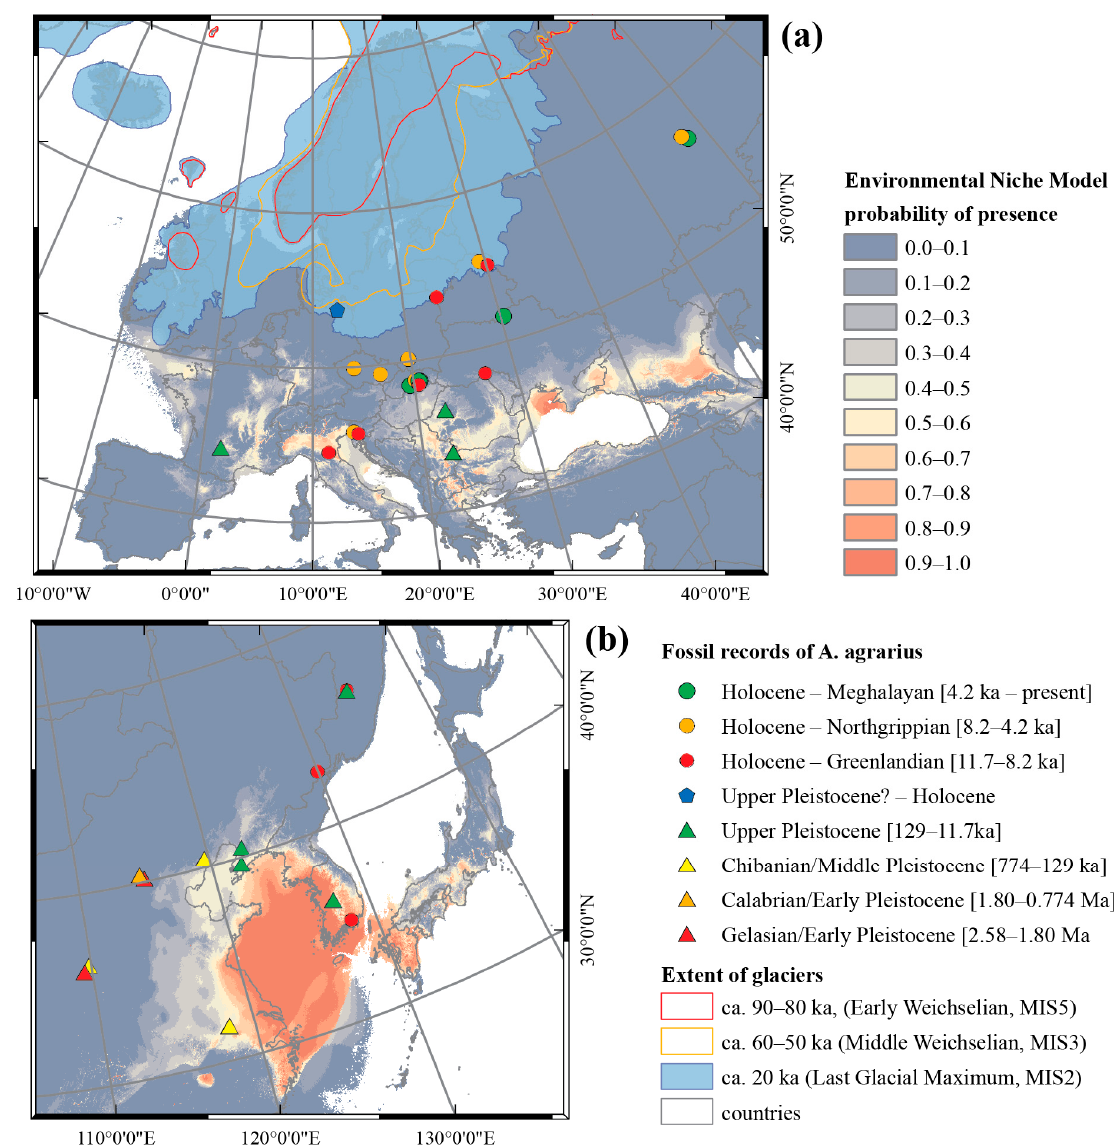
Figure 7. The environmental niche models (ENMs) for A. agrarius during the LGM in clades C1 ( a ) and C3 ( b ). The ENMs were generated in MaxEnt. Fossil records in Eurasia were based on the literature [6,21,65–72].